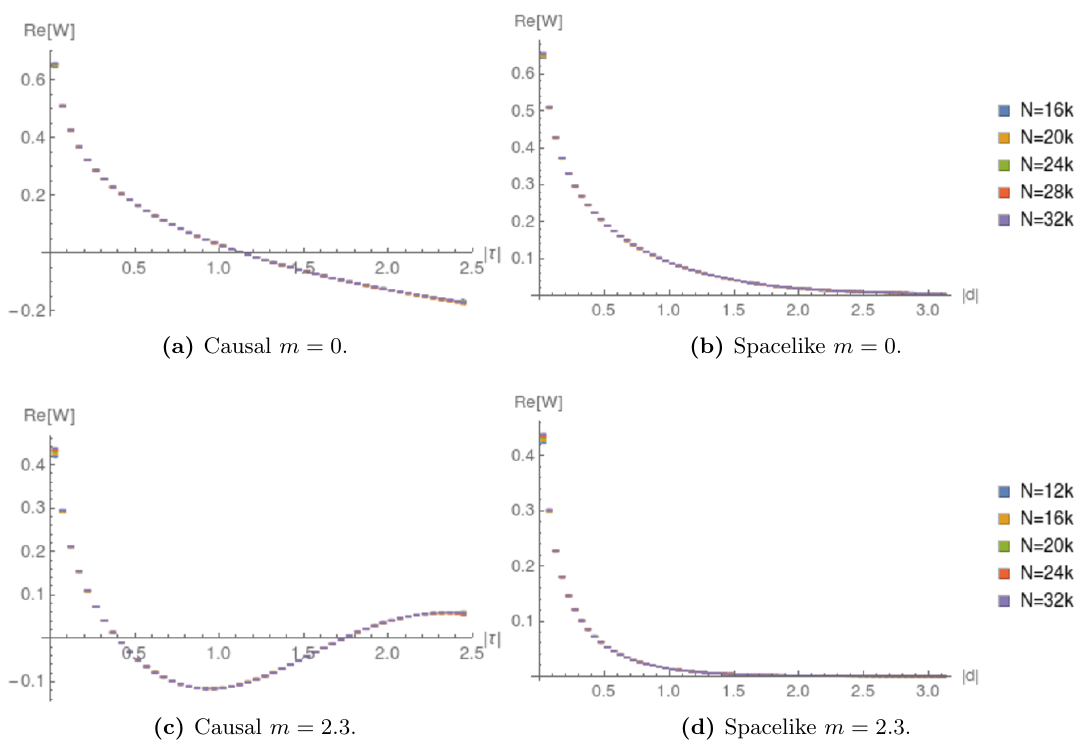
] with density at T = 1, in 2d de SJ